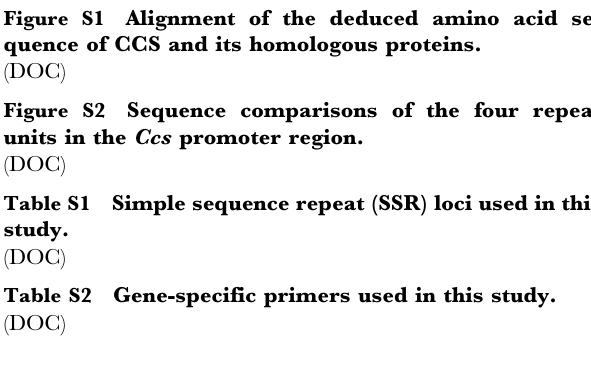
Figure S1 Alignment of the deduced amino acid se- quence of CCS and its homologous proteins. Figure S2 Sequence comparisons of the four repeat units in the Ccs promoter region. Table S1 Simple sequence repeat (SSR) loci used in this study. Table S2 Gene-specific primers used in this